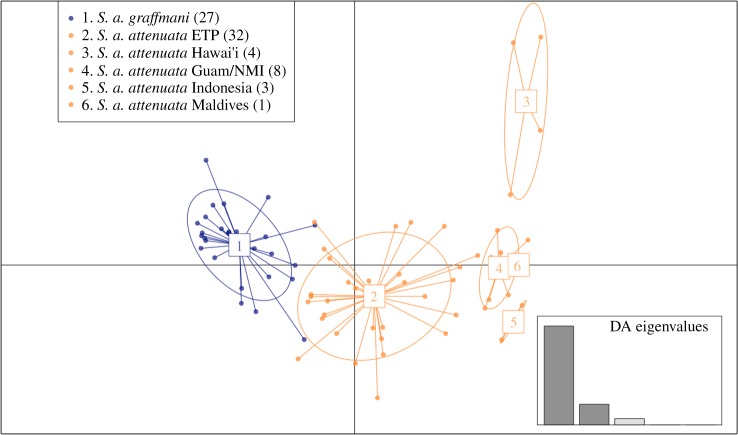
Genomic variation across individuals and populations of spotted dolphins. Scatter plot of individuals based on the first two eigenvalues created from the optimum number of principal components (9) of the DAPC. Ellipses represent 67% of the variation for each population. Maldives (6) is only one sample. Inset shows the amount of variation represented by the DA eigenvalues. Points and ellipses are coloured by subspecies (orange = S. a. attenuata; blue = S. a. graffmani).